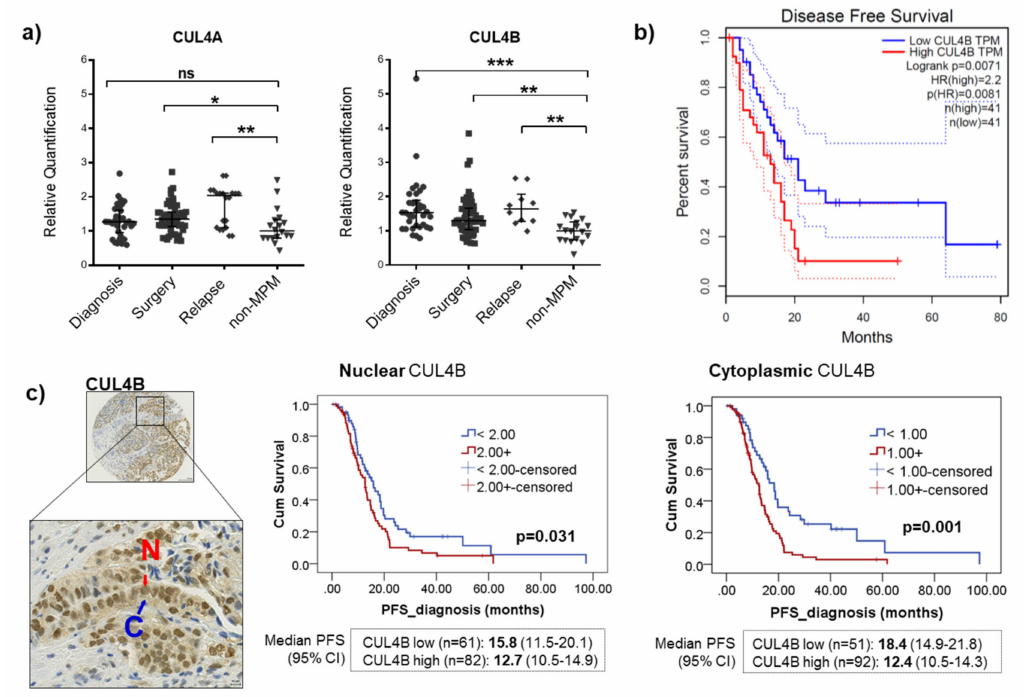
Figure 1. Significance of CUL4A and CUL4B expressions in malignant pleural mesothelioma (MPM). ( a ) qPCR analysis showing the upregulation of CUL4A and CUL4B gene expressions in a subset of MPM tissues collected at various time points (diagnosis ( n = 34), surgery ( n = 50) and relapse ( n = 10)) compared to non-MPM tissues ( n = 18). We used β -actin as a reference gene and the median threshold cycle di ff erence between CUL4A or CUL4B compared to β -actin ( ∆ Ct) of the non-MPM